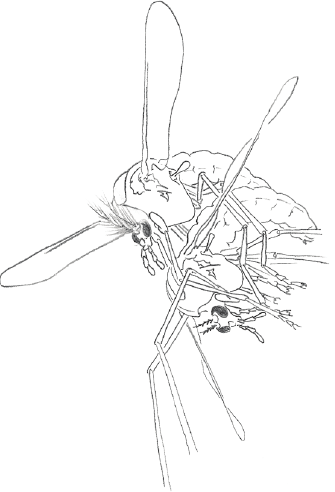
Figure 3: A male/female mating pair of chironomid midges ( Chironomus plumosus ). The male, with plumose antennae, grasps the female, below. Wing length c. 2 mm (drawing by B.